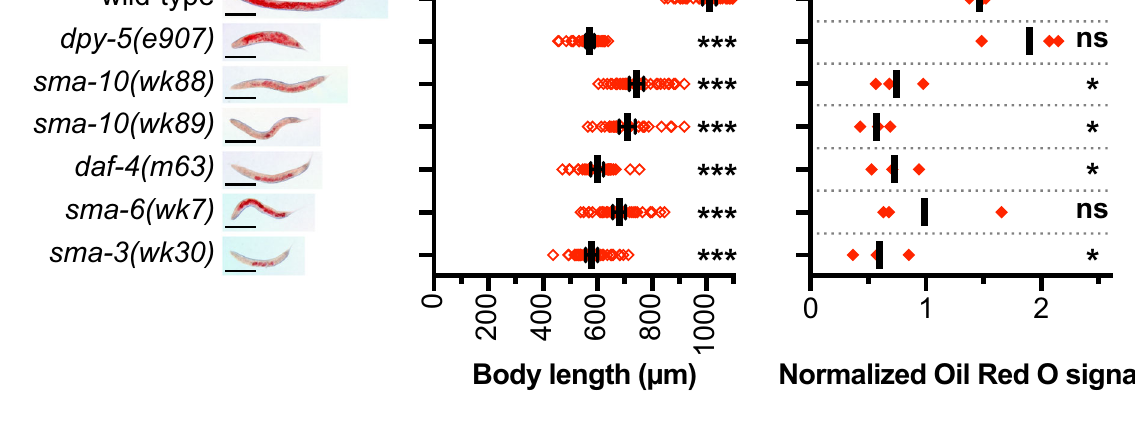
accumulation. For unknown reasons, the sma-6(wk7) series showed a higher variance than the other BMP mutants, which might have contributed to the lack of signi fi cance for this series. Despite being short, the dpy-5(e907) mutants had normal levels of lipid deposits in lipid-storing intestinal cells. Short body length per se thereby appears uncoupled from fat accumulation in somatic tissue of C. elegans . Hence, we conclude that LRIG / sma- 10 promotes lipid accumulation in postmitotic tissue of C. ele- gans , likely through BMP signaling and independent of body size Human LRIG1 variants are associated with an altered risk of type 2 diabetes and with BMI and adipocyte morphology . To